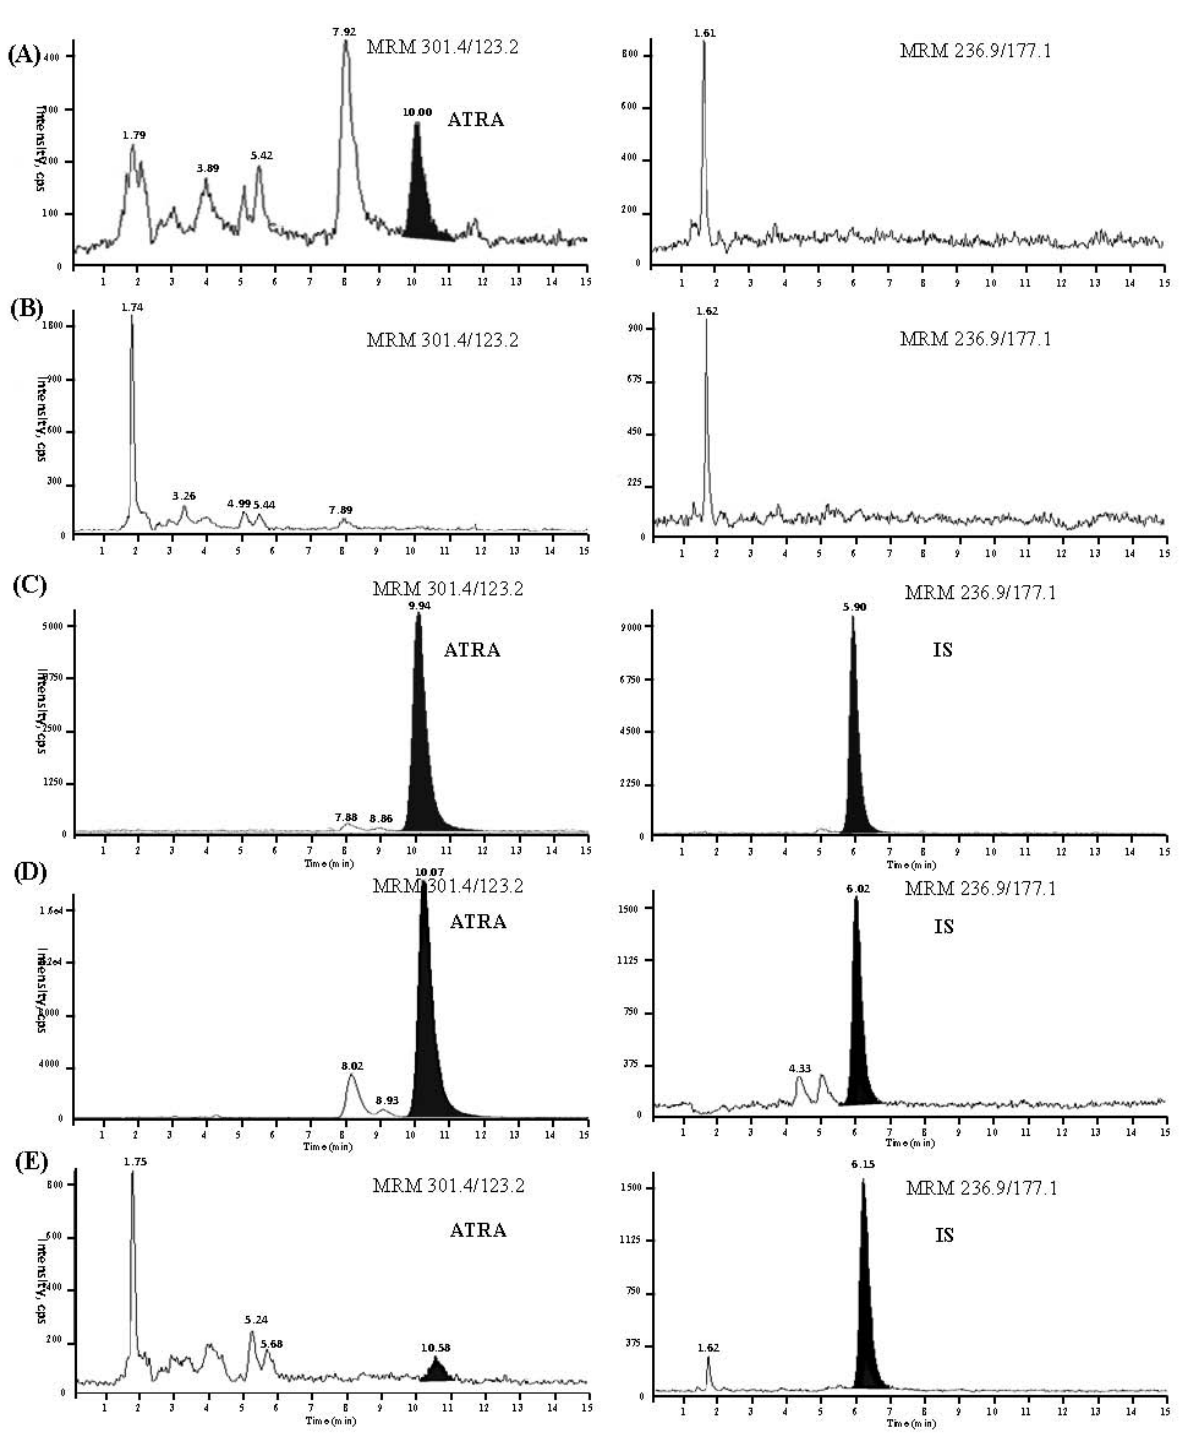
Figure 2. The typical MRM chromatograms of a blank plasma ( A ), a blank plasma with sunshine exposure treatment ( B ), a plasma sample with sunshine exposure treatment spiked with ATRA (108.5 ng/mL) and IS (114.4 ng/mL) ( C ), a plasma sample from a healthy volunteer 2 h after oral administration of 20 mg ATRA ( D ), and ATRA at the LLOQ with IS ( E